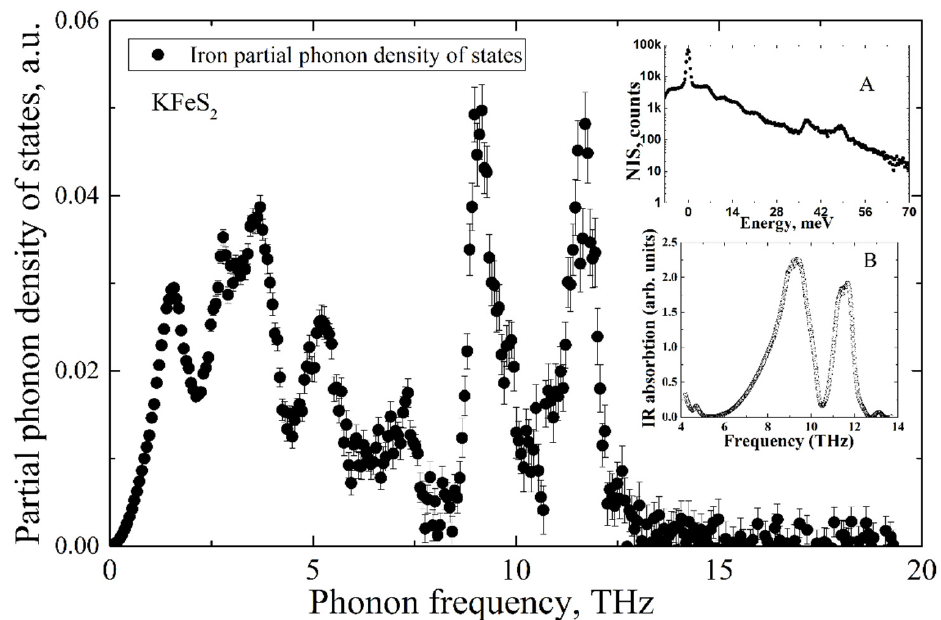
Figure 5. Partial iron PDOS of KFeS 2 evaluated from the nuclear inelastic scattering spectrum of KFeS 2 (presented in the inset A) and IR-absorption spectrum (presented in inset B).